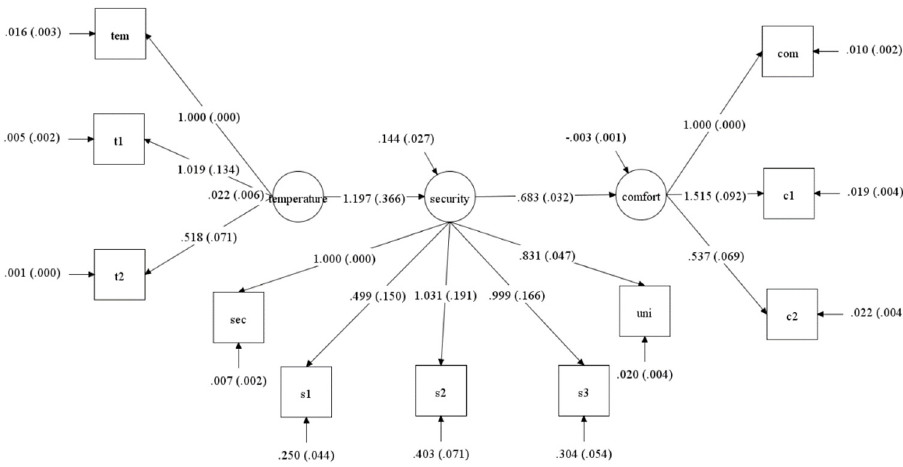
Figure 14. Run results of the comfort evaluation model.